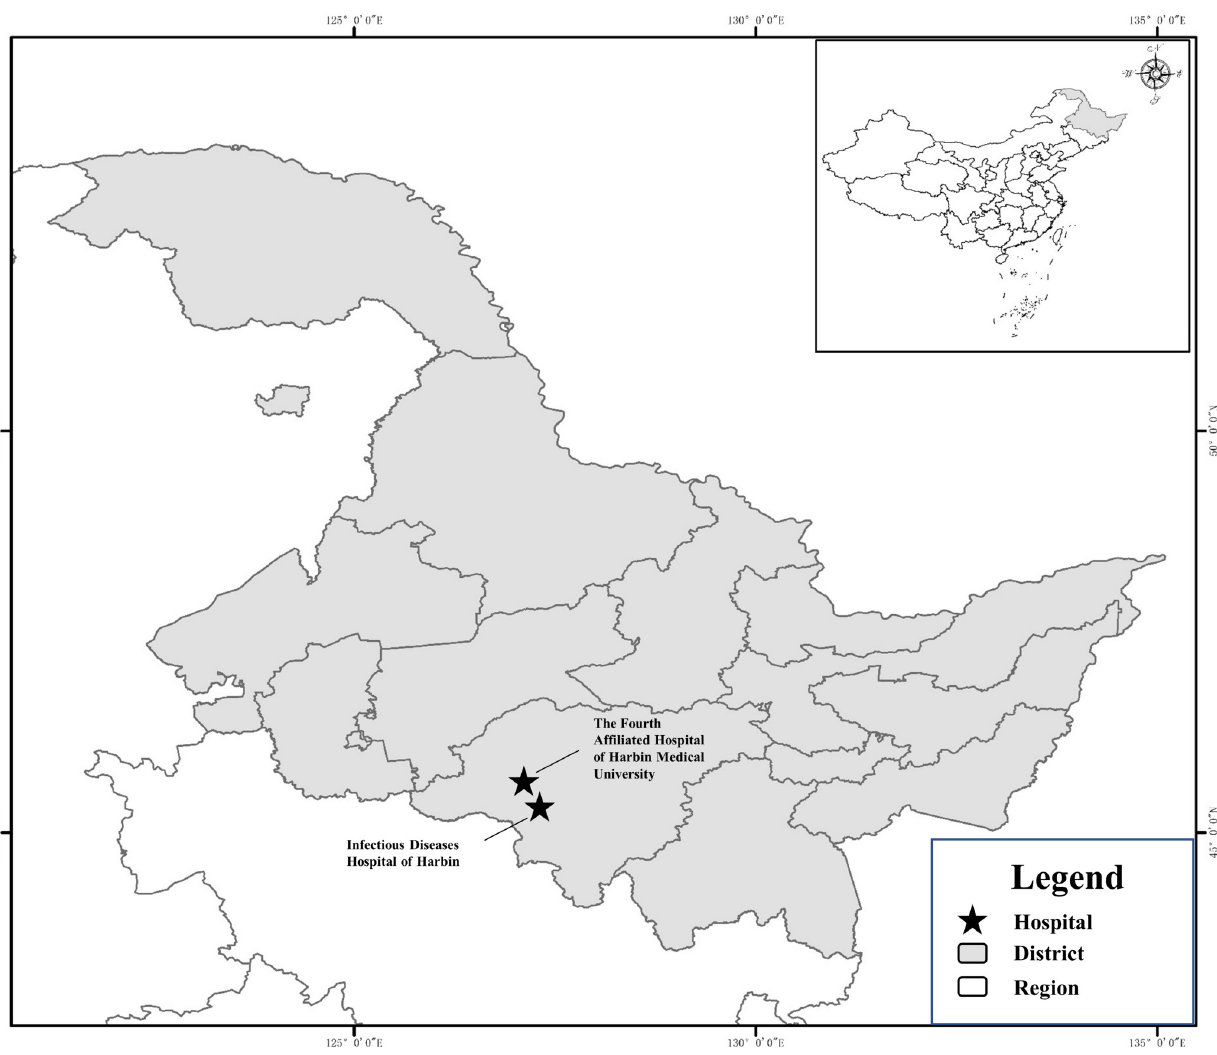
Fig 1. Map of the two hospitals where samples were collected location in Heilongjiang Province, China. The map was originally designed using the software ArcGIS 10.4. The original vector diagram was adopted from National Geomatics Center of China (http://www.ngcc.cn). The map has been modified and assembled according to permission and attribution guidelines using Microsoft PowerPoint 2003 and Adobe Photoshop